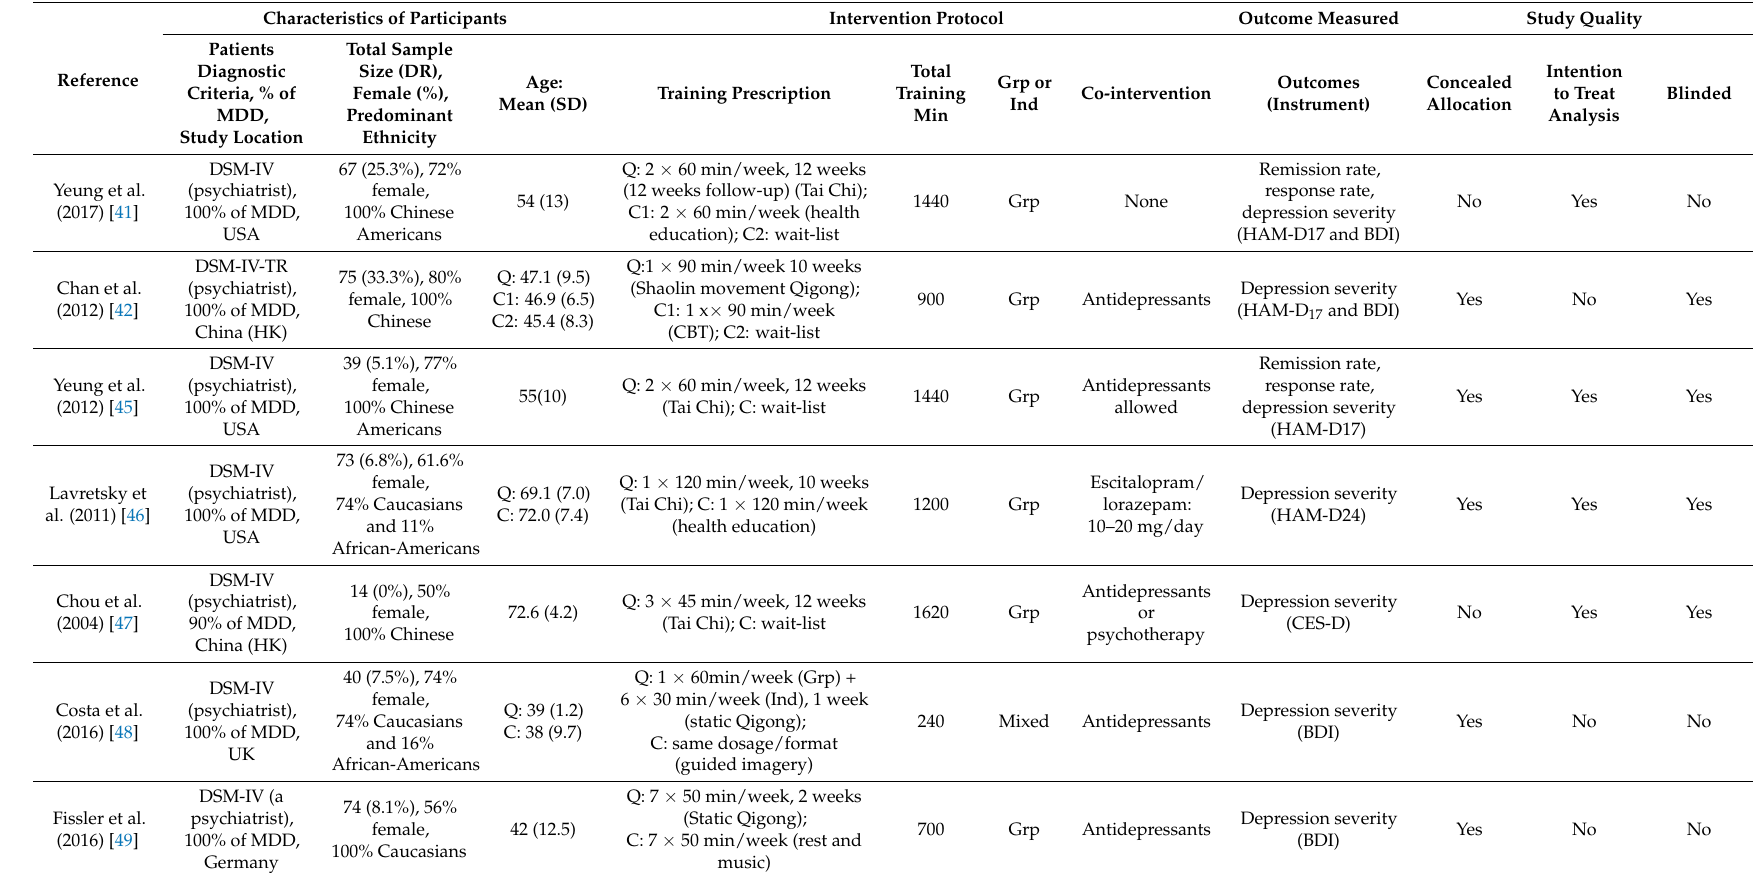
Table 1. Characteristics of the eligible randomized controlled